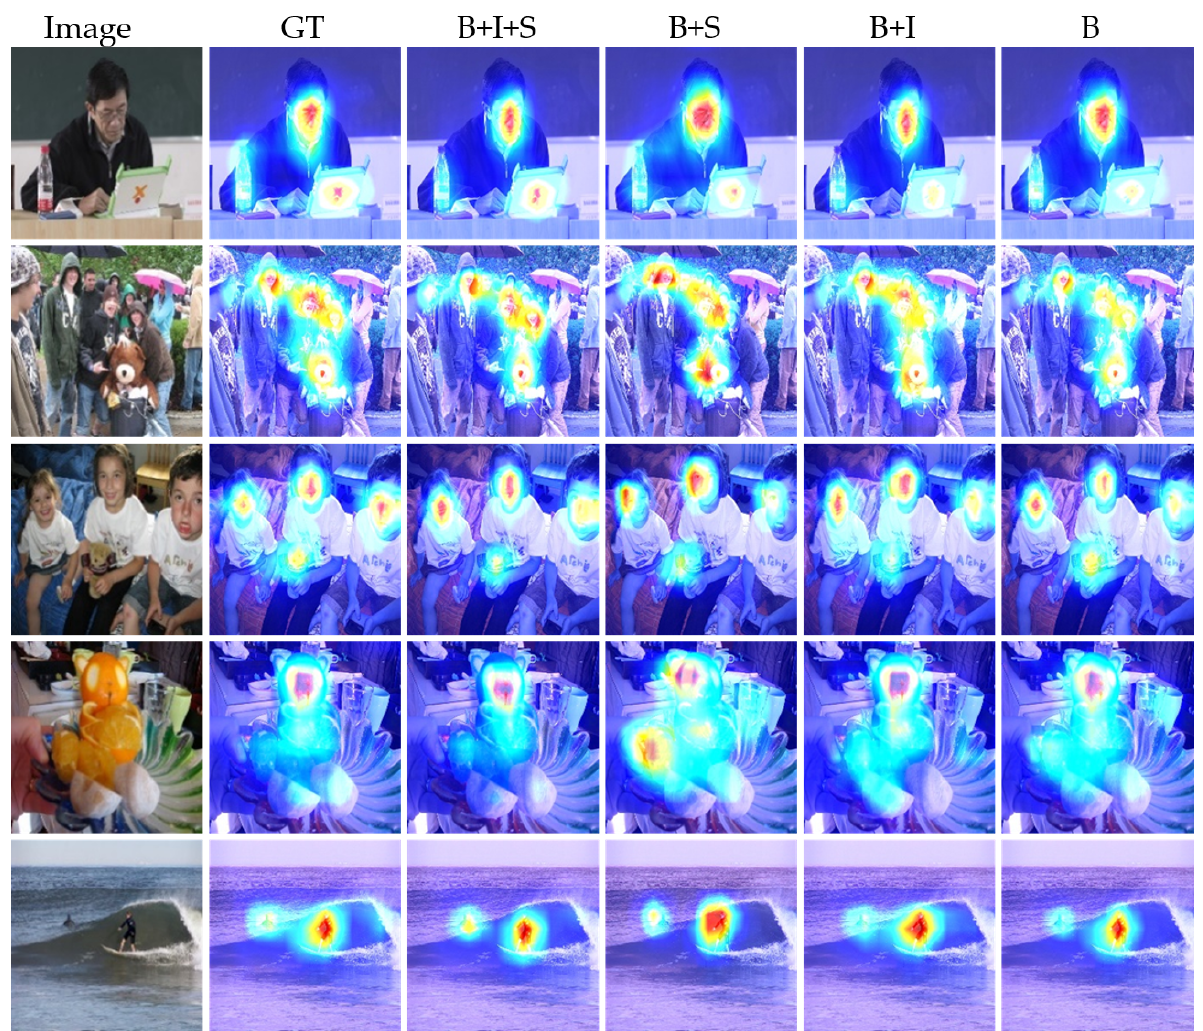
Figure 4. Visualization results of model ablation test on the Cat2000 dataset. We quantized the image saliency from 0 to 1. Approaching 0 is blue and approaching 1 is red.